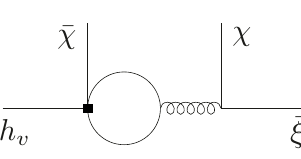
Figure 1 . Fermion lines and associated SCET and HQET (cid:12)elds. The black square denotes an insertion of an operator from the e(cid:11)ective weak